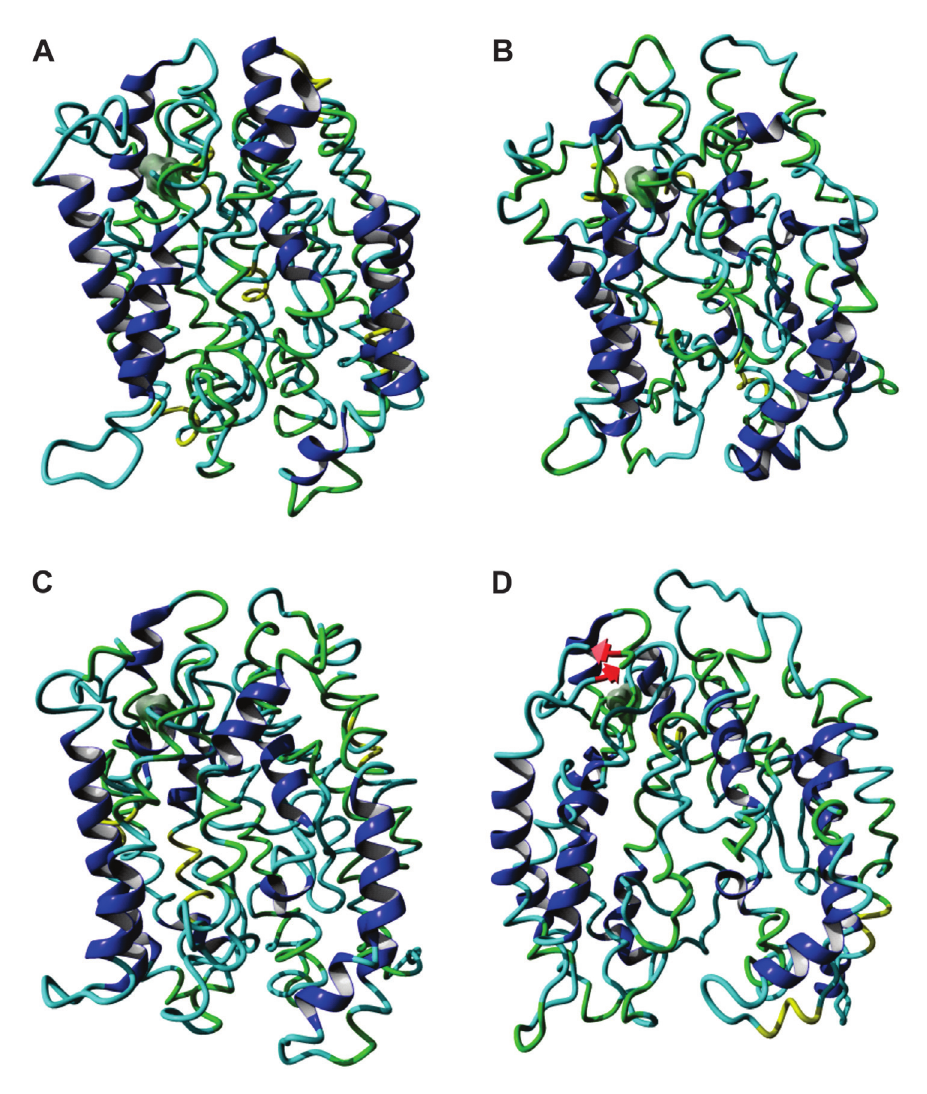
Figure 3 - Molecular models of the HvAACT1 proteins that differed only at residue 172, namely, L-172 (A, B) and V-172 (C, D) . The left panels refer to thesituationatthestartofthedynamicanalysisandtherightpanelsrefertotheaveragestructureobtainedduringthedynamicanalysis(20ns).Greycloud represents the position of residue